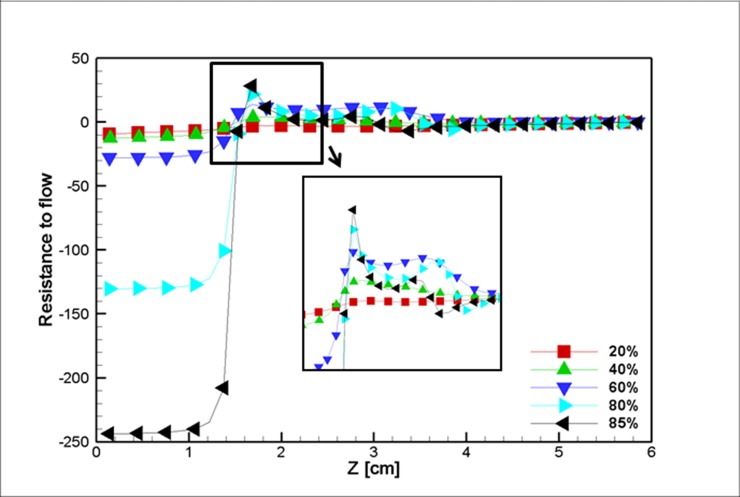
Resistance to the flow for five different stenosis blockage percentages over the midline of the blocked vessel at the middle of the simulation, t = 0.5 s, Lvessel = 6 cm, Rvessel = 1 cm.